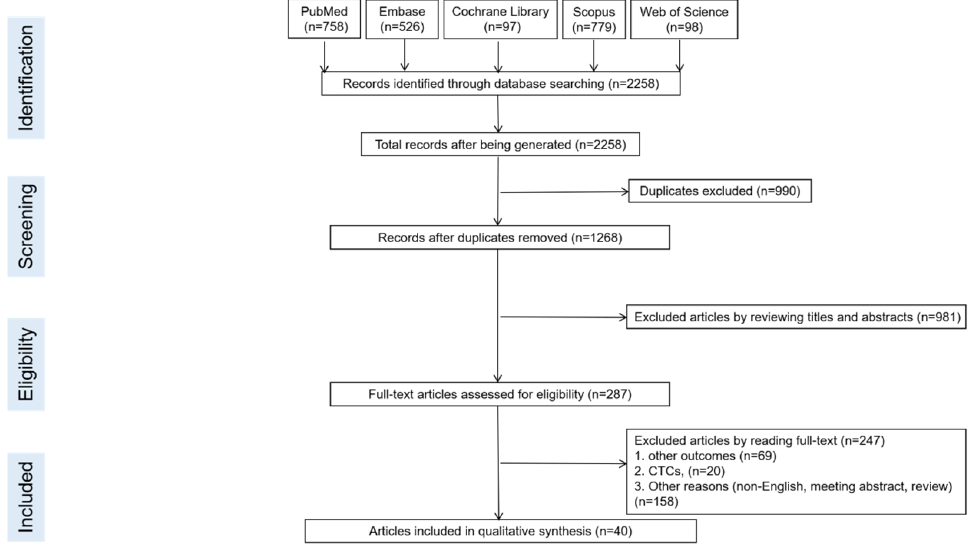
Figure 1. Flow diagram illustrating the selection of the included studies.